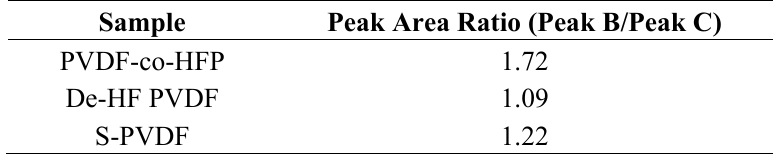
Table 3. Peak area ratio of Peaks B and C in the high-resolution C1s